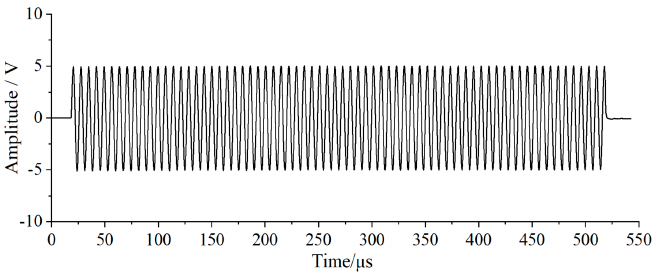
Figure 8. Sine wave after modulation.